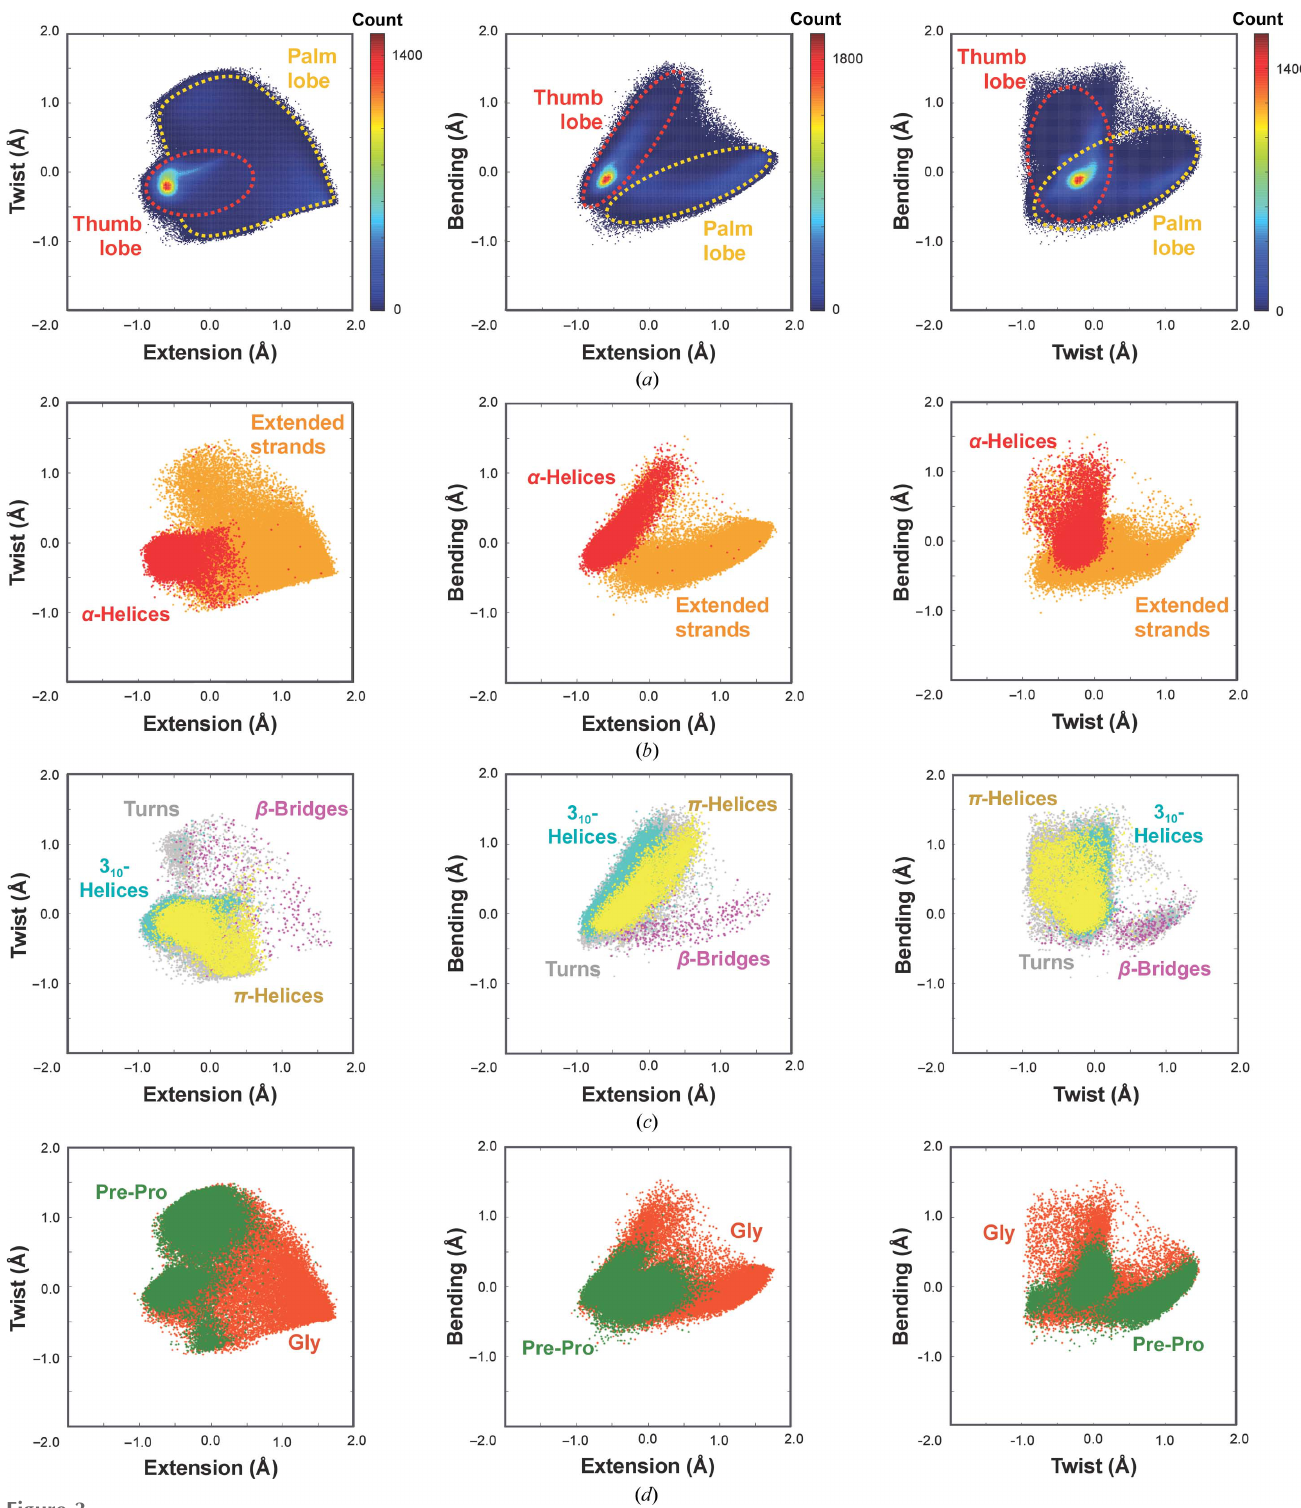
Figure 3 Representation of the three-dimensional DipSpace. ( a ) Joint distribution of pc 1 (extension) and pc 2 (twist), pc 1 (extension) and pc 3 (bending), and pc 2 (twist) and pc 3 (bending). The two main lobes are marked by dashed lines. Distribution of ( b ) (cid:2) -helices and extended strands, ( c ) turns, (cid:8) -bridges, (cid:11) -helices and 3 10 -helices, as annotated by DSSP , and ( d ) glycine and pre-proline residues (the identity corresponds to the middle C (cid:2) atom of the dipeptide